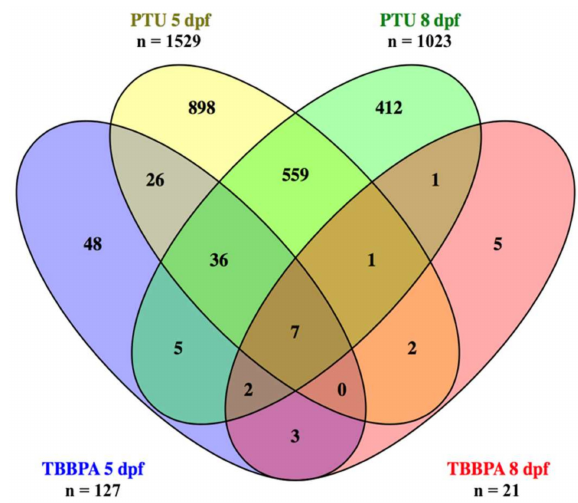
Figure 1. Number of differentially expressed transcripts in the different treatments and intersects between them. 5 dpf (days post fertilization) = continuous exposure from 0 to 5 dpf; 8 dpf = exposure until 5 dpf + 3 days of